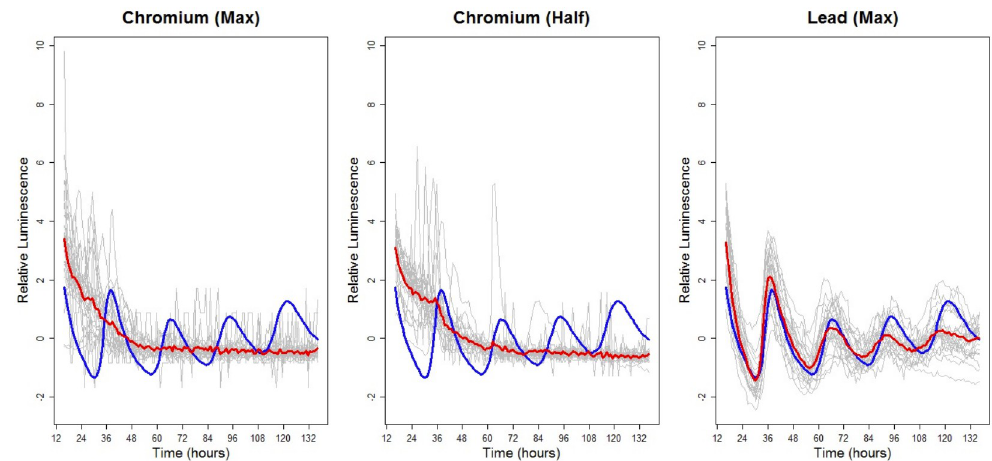
Fig 5. Examples of variability within and between treatments: Luminescence profiles over time for A. thaliana plants exposed to (different concentrations of) Chromium and Lead (see Table 1 for more details). Each panel: individuals in the treatment group (grey) are shown along with the treatment group average (red) and the control group average (blue). Each time series has been standardised to have mean zero.